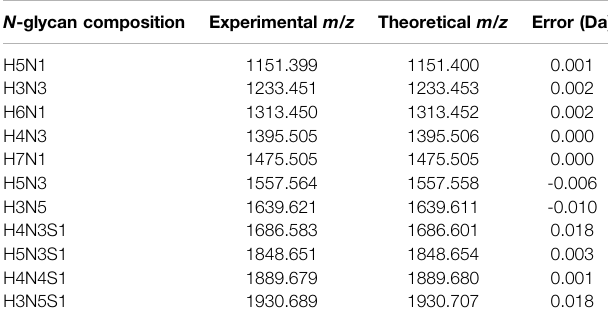
TABLE 1 | The N -glycan compositions released from bovine LPO by